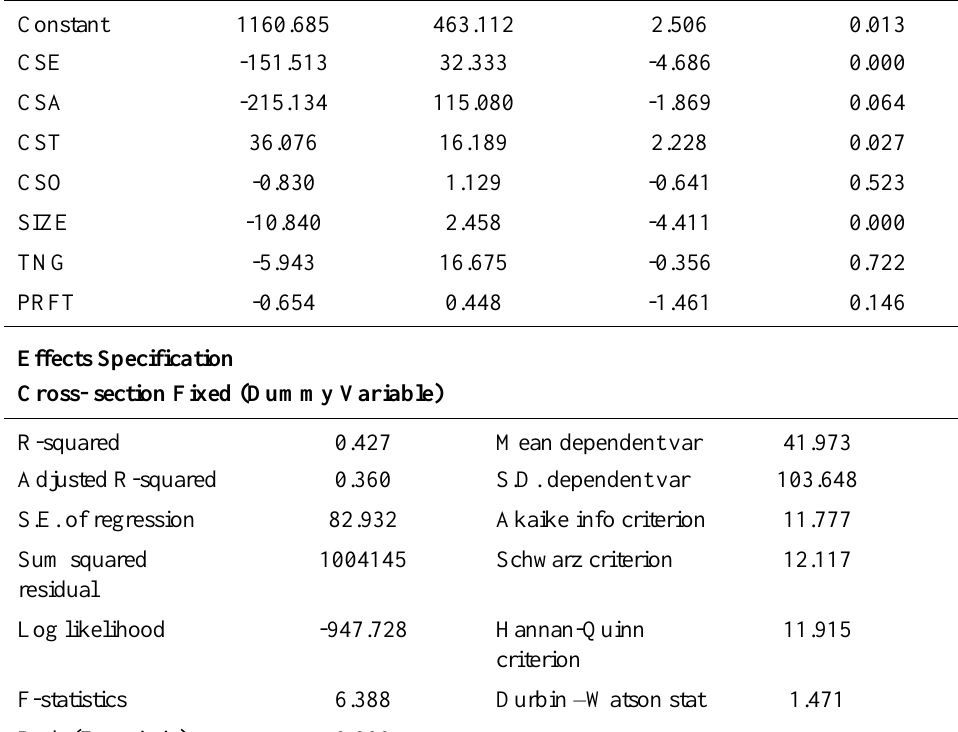
Table 5: Model Estimation